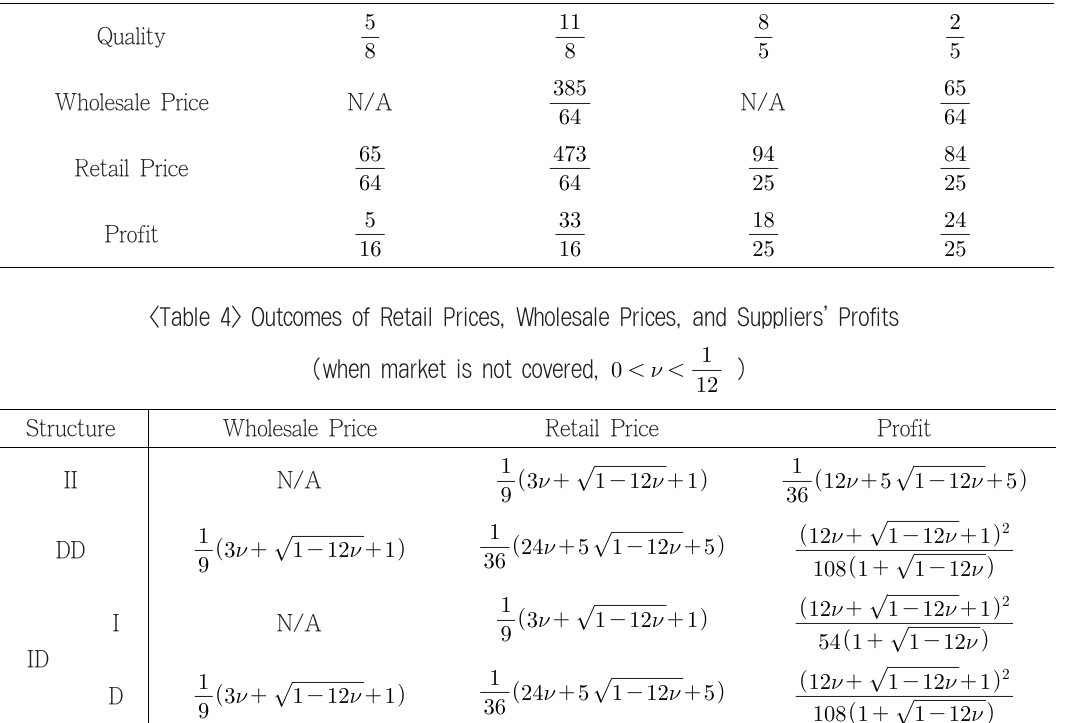
<Table 3> Outcomes of Quality, Retail Prices, Wholesale Prices, and Suppliers’ Profits (when the market is covered,  is sufficiently large)